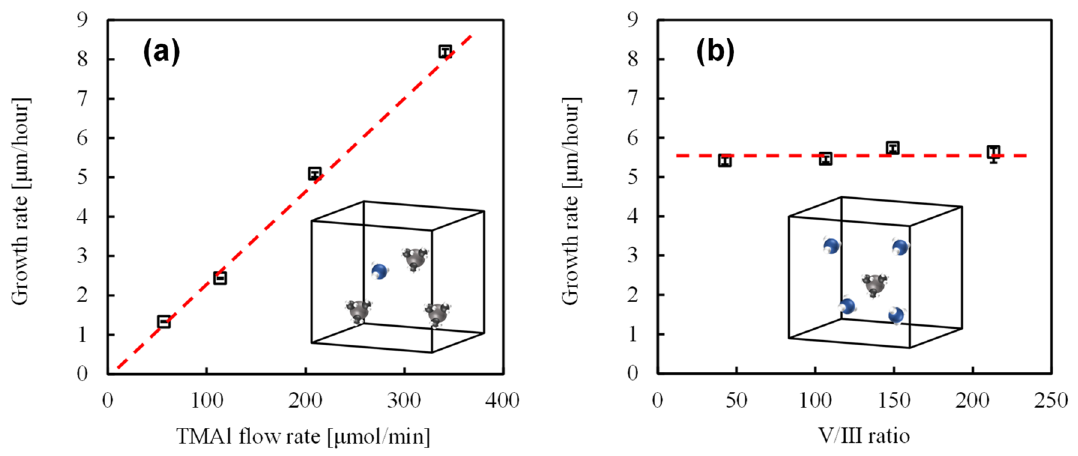
Figure 4. Evidence of suppressed parasitic reaction at an increasing growth rate at a gas flow velocity of 16.5 m/s. ( a ) AlN growth rate vs. TMAl flow rate. Increasing Al source concentration in certain areas result in adduct formation and growth rate saturation; ( b ) Dependence of AlN growth rate on ammonia flow rate. Increasing N source concentration in a certain area increases the adduct formation probability, similar to ( a ). The growth rate decreases with an increasing ammonia flow rate in the case of adduct